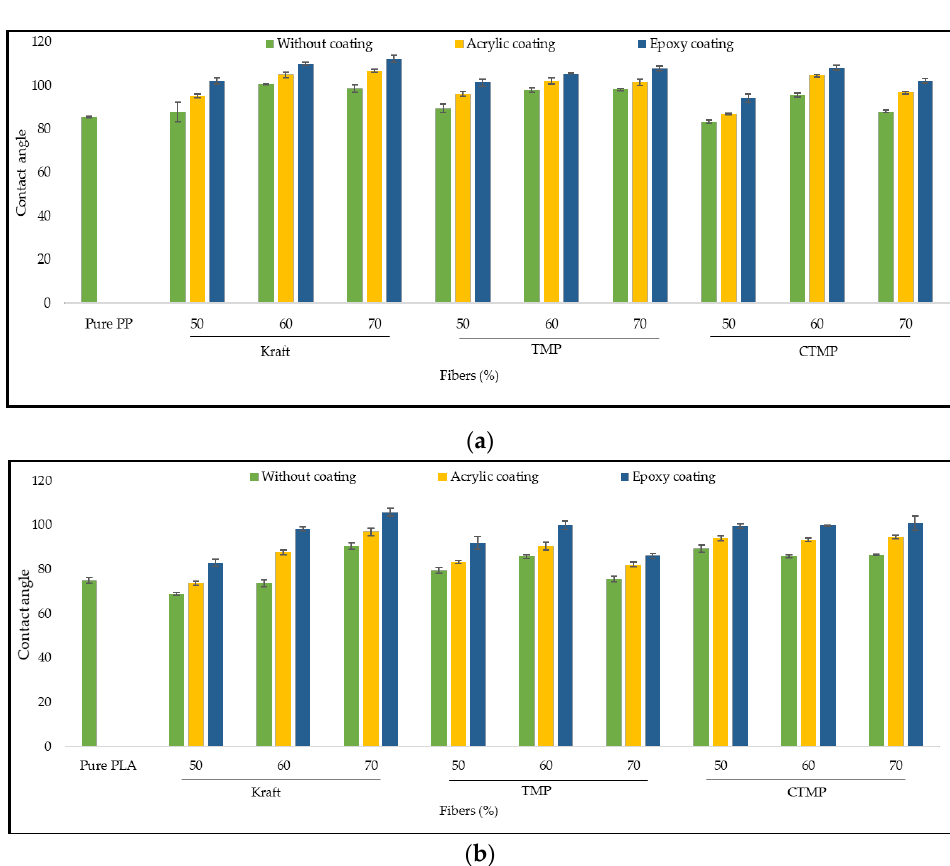
Figure 1. Contact angle measurements before and after coating. ( a ) Contact angle of PP-based composites and ( b ) Contact angle of PLA-based composites.